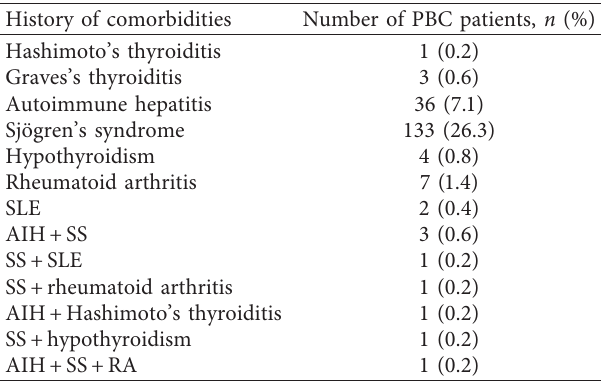
Table 1: Clinical comorbidities in patients with primary biliary cholangitis ( n �